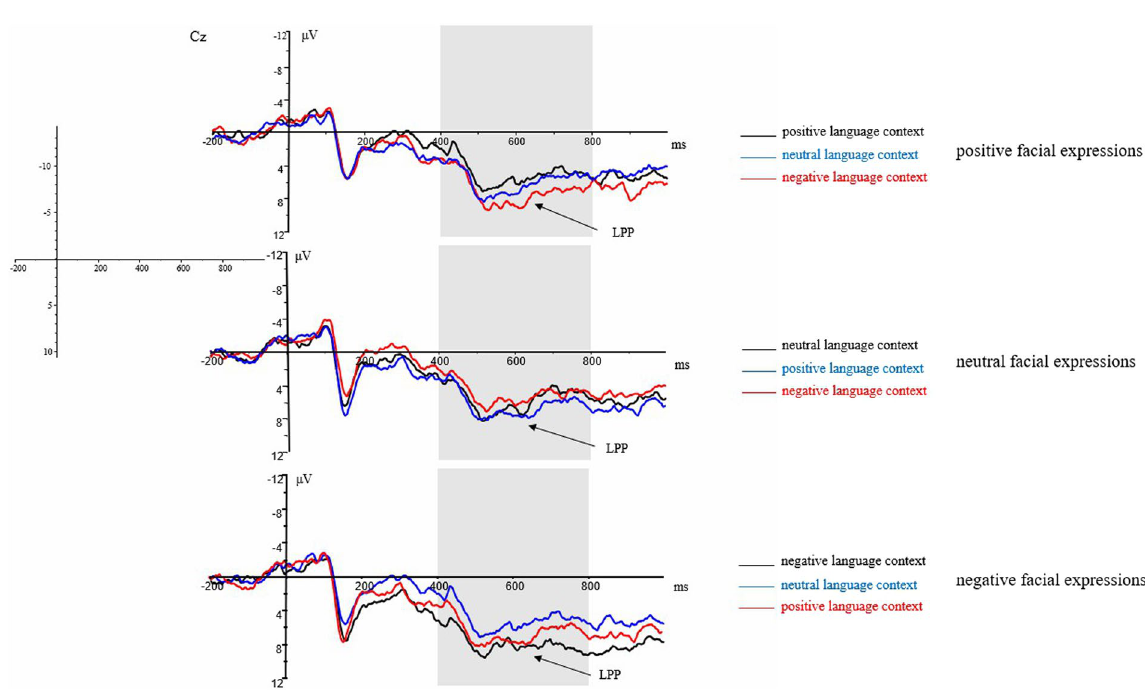
Figure 4. The grand-average ERPs elicited by positive, neutral, and negative facial expressions in different language contexts at Cz